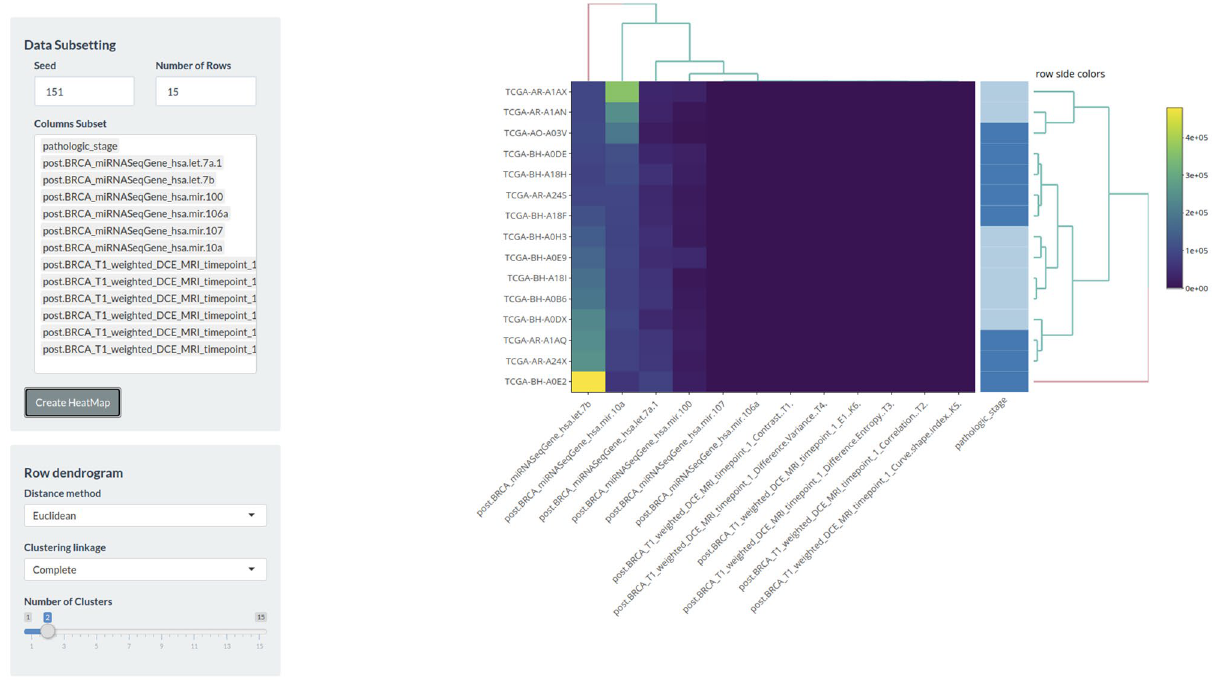
Figure 7. An example of downstream analysis module. Heatmap module is one of the downstream analysis modules. In this case, on the left-hand side, the user can choose the features to view in the heatmap and can set distance method, i.e., clustering linkage, number of clusters and other parameters that also define the graphical aspect of the heatmap. Other downstream analysis modules are based on the same structure. The figure is generated by using R software version 3.6.1 (https ://www.r-proje ct.org).